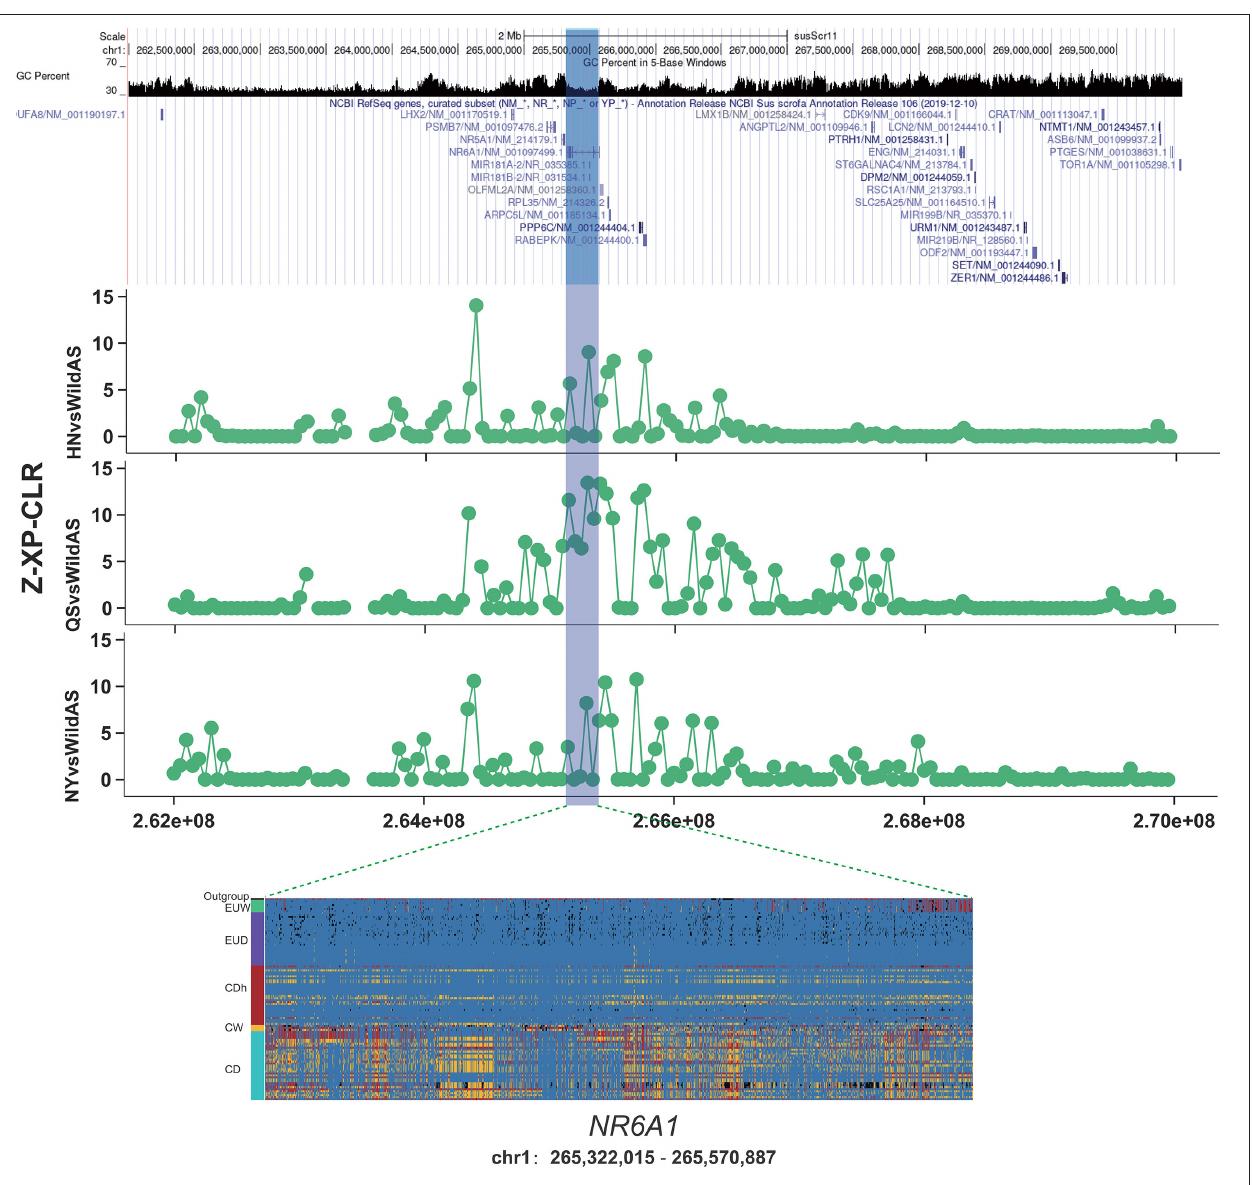
FIGURE 4 | Introgression at the NR6A1 locus. XP-CLR showed a significant selection signature located in the NR6A1 gene in Henan indigenous pigs compared to Chinese wild pigs. Results from genotyping a diverse panel of European and Chinese pigs for SNPs in the putative selective sweeps containing NR6A1